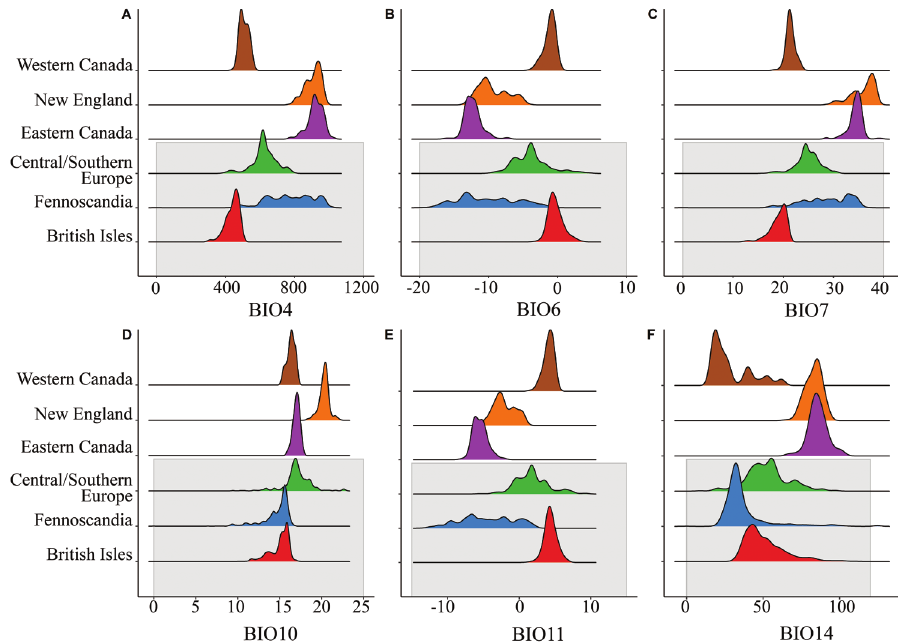
Figure 4. Distribution of bioclimatic variables among occurences within various geographic bins. Gray shading represents winter moth records in the native range. Bioclimatic variables found to contribute the most for each model area shown here, panel A shows BIO4 (temperature seasonality, standard deviation *100), panel B shows BIO6 (minimum temperature of coldest month, ° C ), panel C shows BIO7 (tem- perature annual range, ° C ), pancel D shows BIO10 (mean temperature of warmest quarter, ° C ), panel E shows BIO 11 (mean temperature of coldest quarter, ° C ) and panel F shows BIO 14 (precipitation of driest month, mm